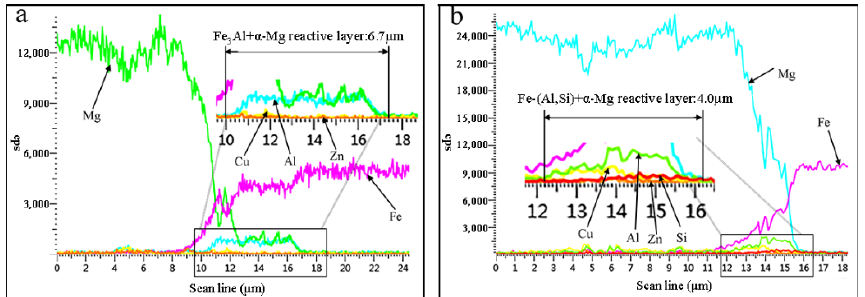
Figure 8. EDS line scanning of line A and line B of magnesium alloy/steel interface in Figure 6: ( a ) line A (Cu − 0%Si) and ( b ) line B (Cu − 5%Si).